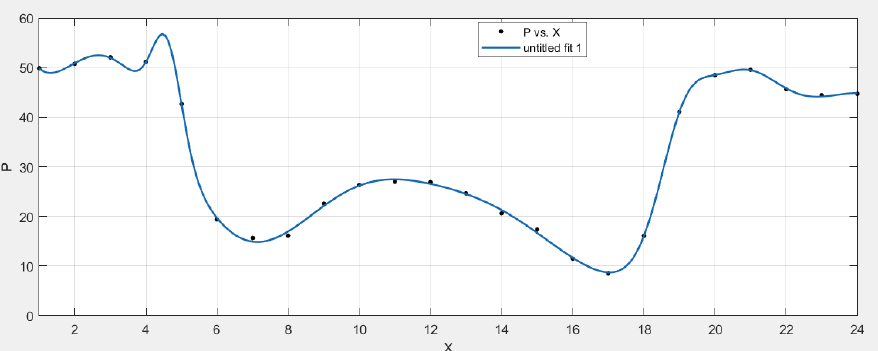
Figure 6. The Gaussian Fitting for one average period.